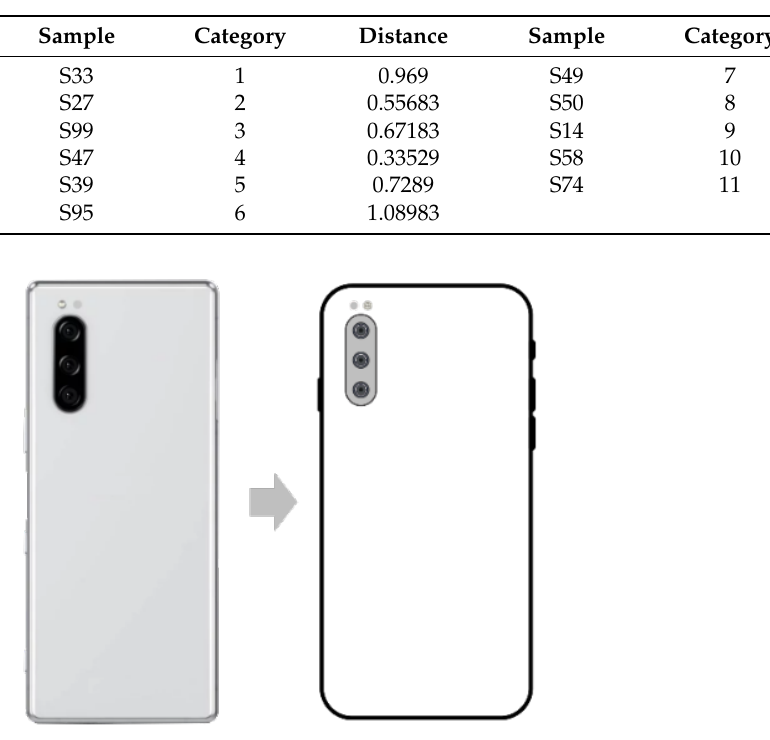
Figure 5. Representative samples converted into 2D images.